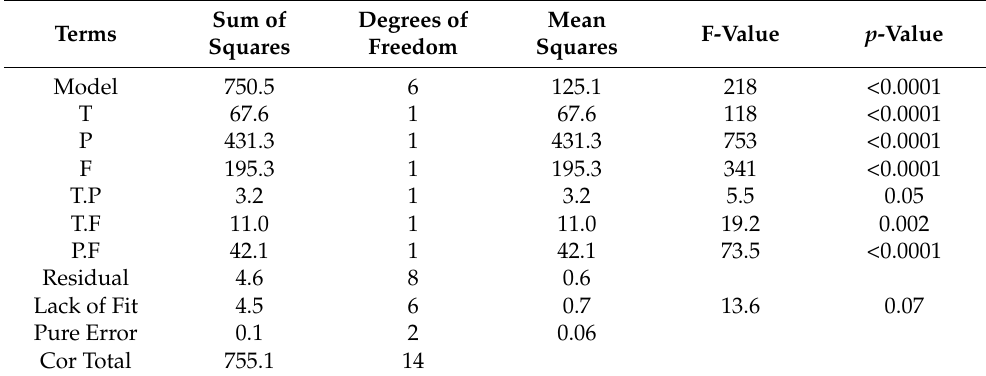
Table 2. Data on ANOVA for oil obtained using Box–Behnken experimental design of a three-variable system for CO 2 extractions.